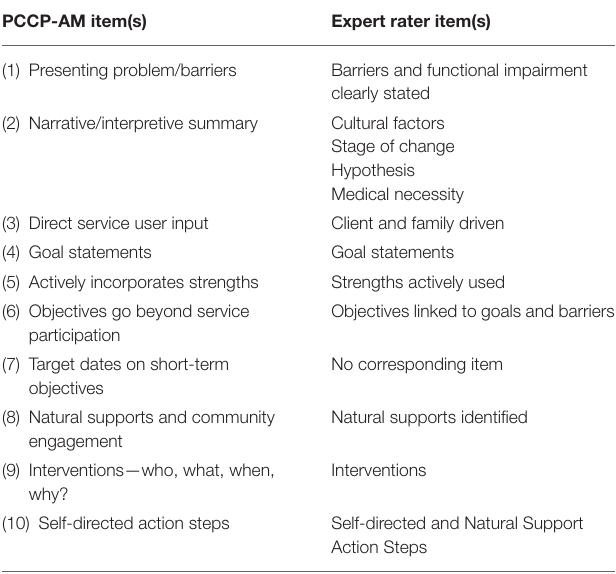
TABLE 1 | Comparison of PCCP-AM items and expert rating instrument items. PCCP-AM